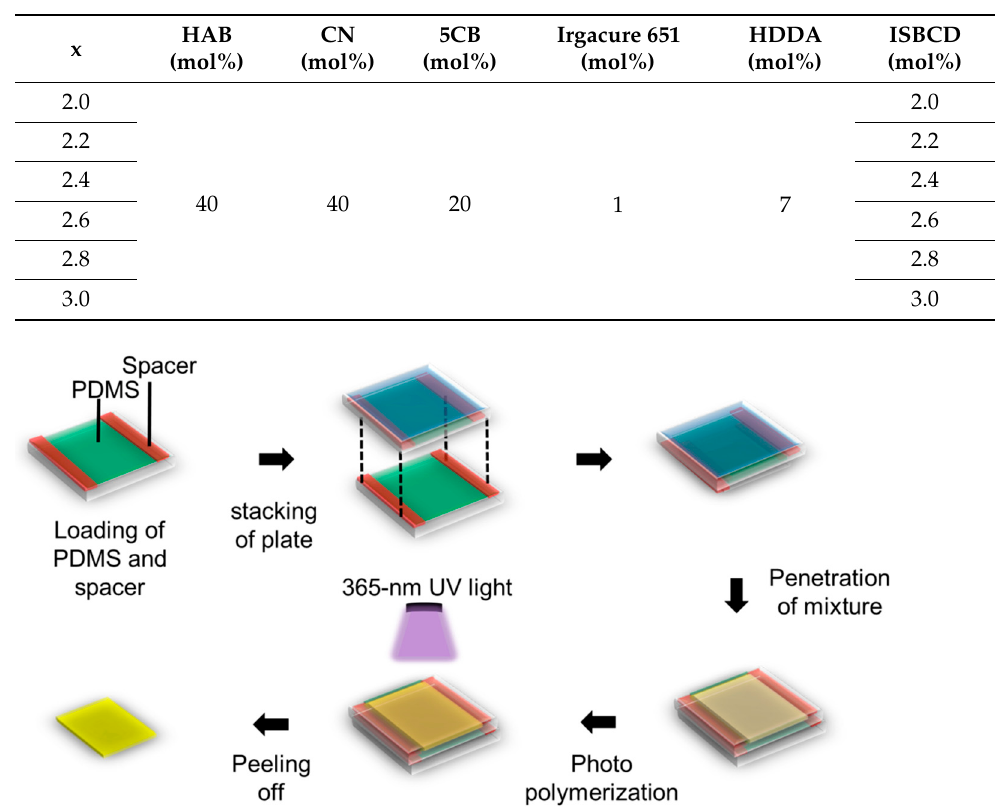
Figure 1. Schematic illustration of the fabrication method for N* LC ( x ) elastomer films.